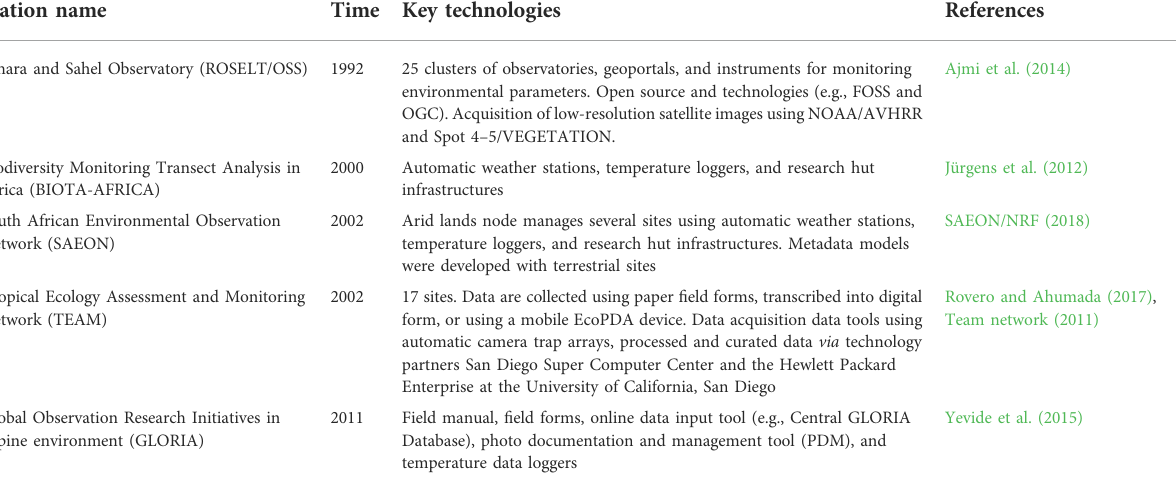
TABLE 1 Examples of African Ecosystem Research Networks (AERNs) dealing with climate change, dryland monitoring, and